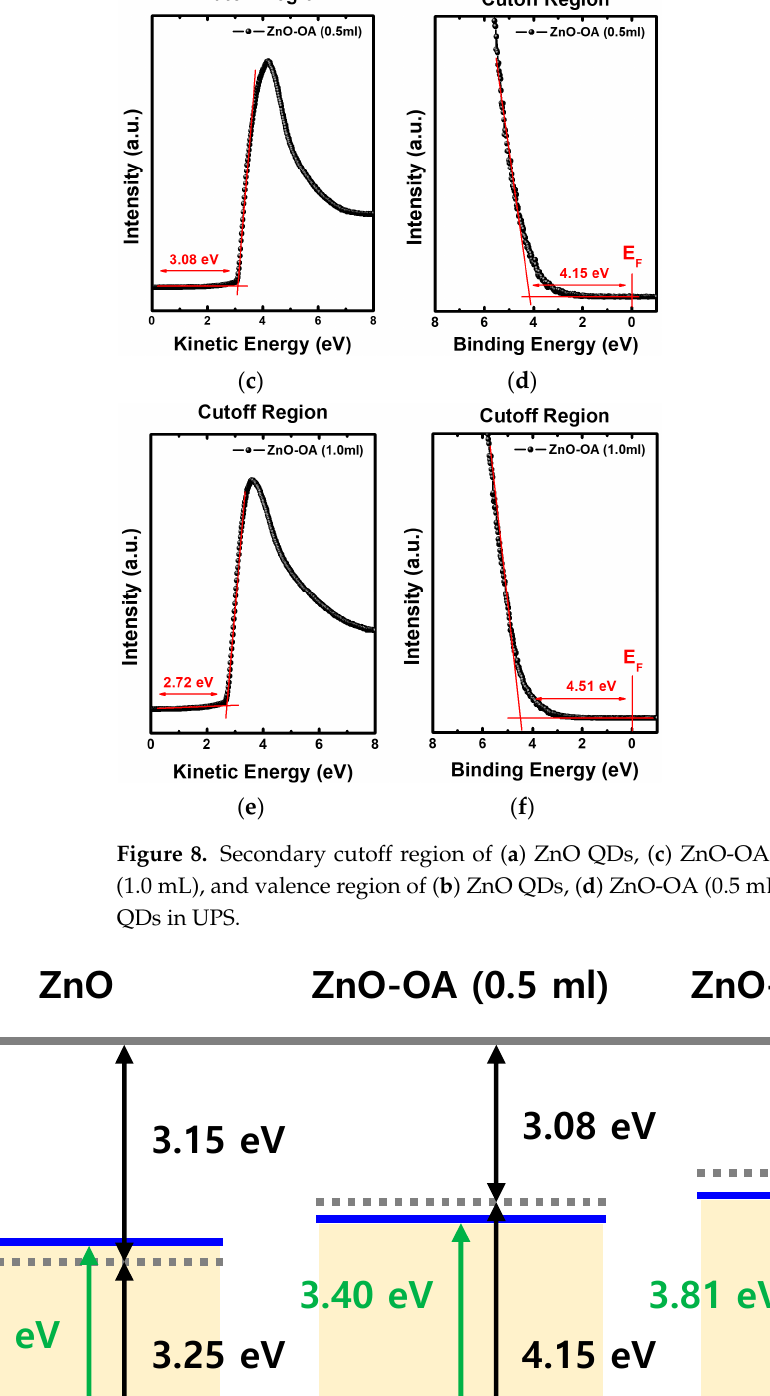
Figure 8. Secondary cutoff region of ( a ) ZnO QDs, ( c ) ZnO-OA (0.5 mL) QDs, and ( e ) ZnO-OA (1.0 mL), and valence region of ( b ) ZnO QDs, ( d ) ZnO-OA (0.5 mL) QDs, and ( f ) ZnO-OA (1.0 mL) QDs in UPS.